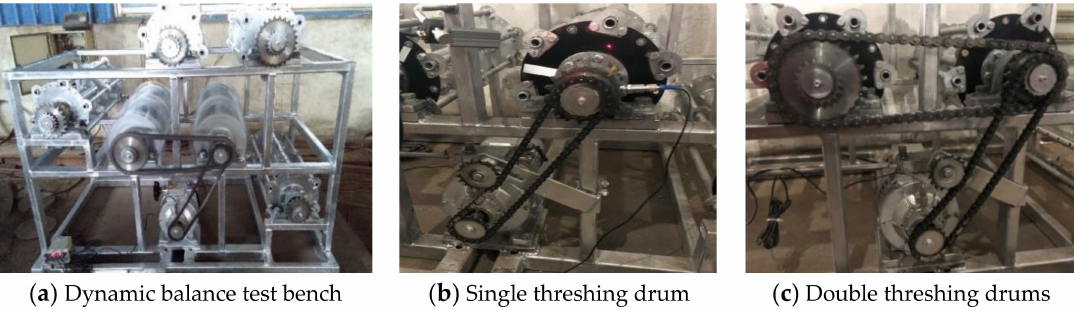
Figure 4. Double threshing drums dynamic balance test bench and chain drive mode